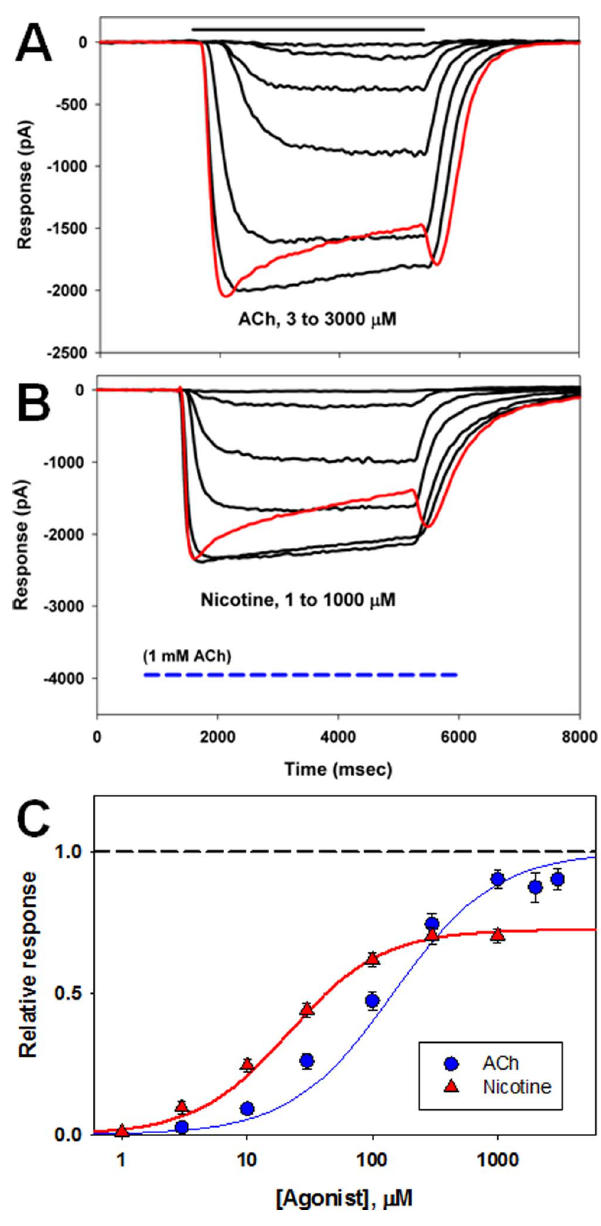
Figure 2. Activation of receptors containing a 3 and wild-type b 4 subunits. Panel A shows responses of a cell to various concentrations of ACh and Panel B shows the response of a different cell to various concentrations of nicotine (applications lasted 4 sec). In Panel B the horizontal dashed line indicates the response of this cell to 1 mM ACh, to estimate the maximal response. The response to the highest concentration of nicotine is clearly less than that to ACh, indicating that the relative efficacy of nicotine is less than that of ACh. Panel C shows the average normalized concentration effect curves for a 3 b 4 receptors (both curves normalized to the maximal response for ACh). The symbols show mean 6 SE. The curves show the predictions of the Hill equation (see Methods): Y(X)=a(1/(1 + (X/EC50)n)) where a is the maximal response, X is the concentration of agonist, n is the Hill coefficient and EC50 is the concentration producing a half-maximal effect. The curves were generated with the overall mean parameters; for ACh EC50 146 6 34 m M and Hill coefficient 1.07 6 0.06 (20 cells), and for nicotine EC50 22 6 4 m M and Hill coefficient 1.17 6 0.07 (9 cells). The maximal response to nicotine relative to the maximal response to ACh (the relative efficacy for nicotine) is 0.73 6 0.03 (17 cells). The baseline holding current before application has been subtracted from all